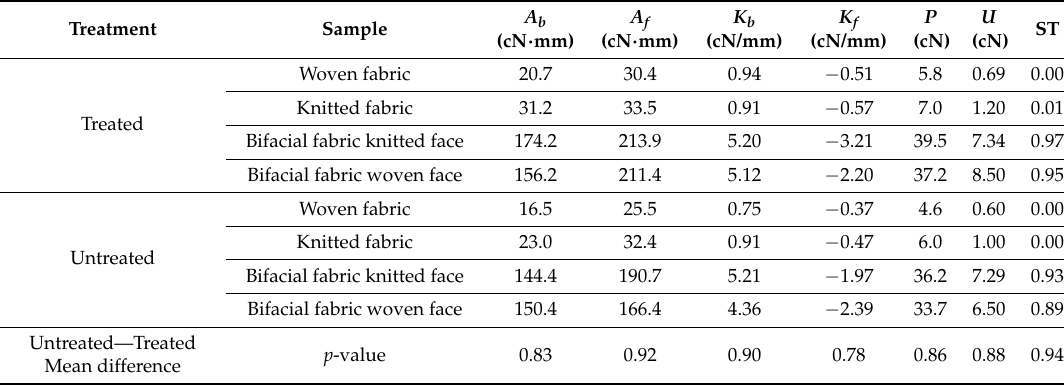
the p-values for judging the differences between the